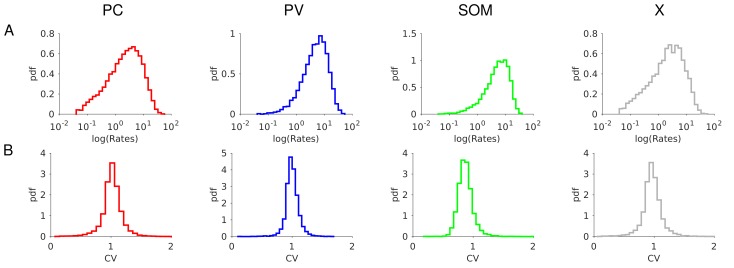
Model 2.Firing statistics at baseline. (A) Distribution of the firing rates (mean: rE = 4.5 HZ, rI = 10.6 Hz, rS = 7.2 hz, rV = 4.9 Hz). (B) Distribution of CV. Individual rates are average over 100s with a threshold at 0.05Hz. CVs are computed over 30s. Color code and parameters as in Figure 10.